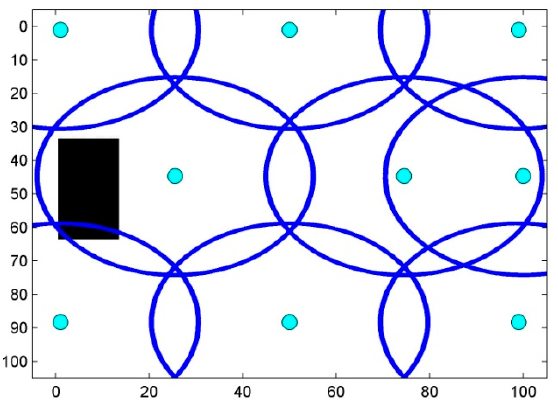
Figure 20. Optimal sensor deployment on area “UL-A”.